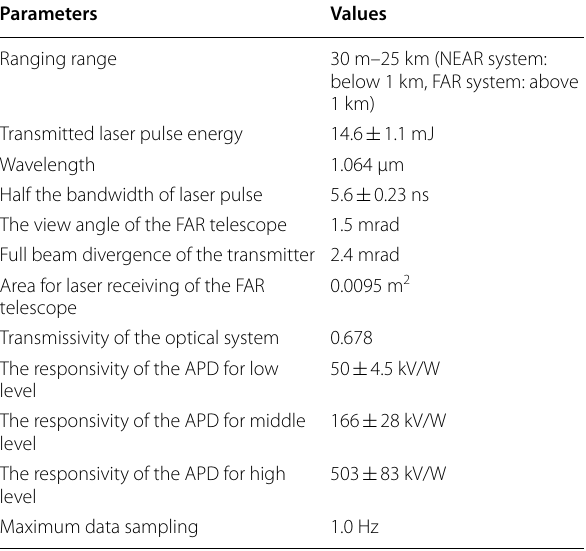
Table 1 Specification of the Hayabusa2 LIDAR (Mizuno et al.